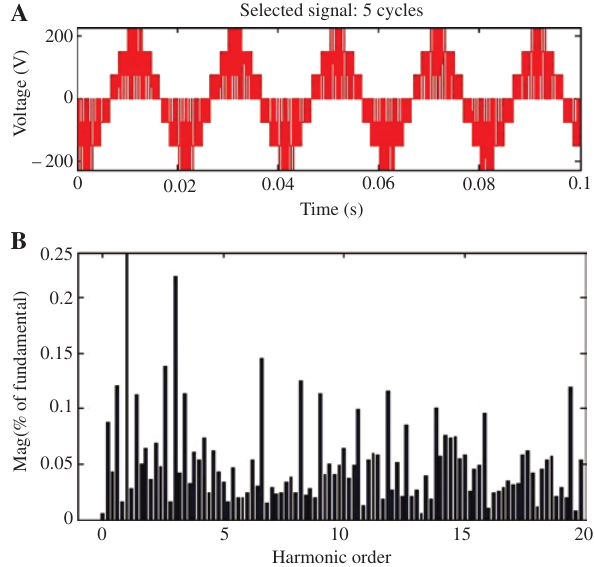
Figure 12: THD Analysis of Output Voltage with NFC. (A) Selected five cycles of voltage. (B) THD.